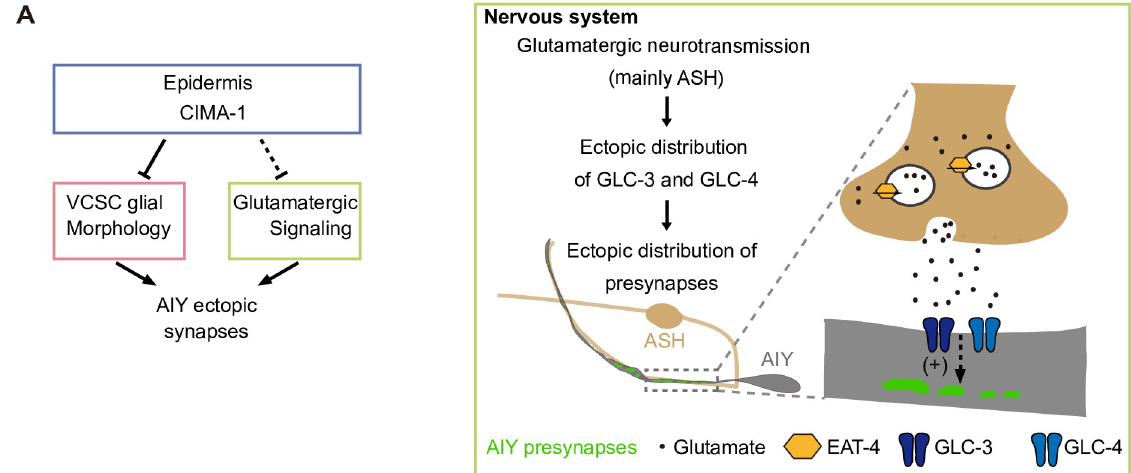
Fig 8. A model explaining the AIY synaptic subcellular specificity. (A) A model explaining the AIY synaptic subcellular specificity. CIMA-1 in epidermal cells regulates the AIY presynaptic subcellular specificity by two pathways: VCSC glia signaling and glutamatergic signals. The glutamatergic signaling, which can also be increased by eat-4(OE) or high cultivation temperature, promotes the ectopic distribution of GLC-3 (dark blue) and GLC-4 (light blue) receptors in the AIY zone 1 region, where these receptors regulate the ectopic presynaptic